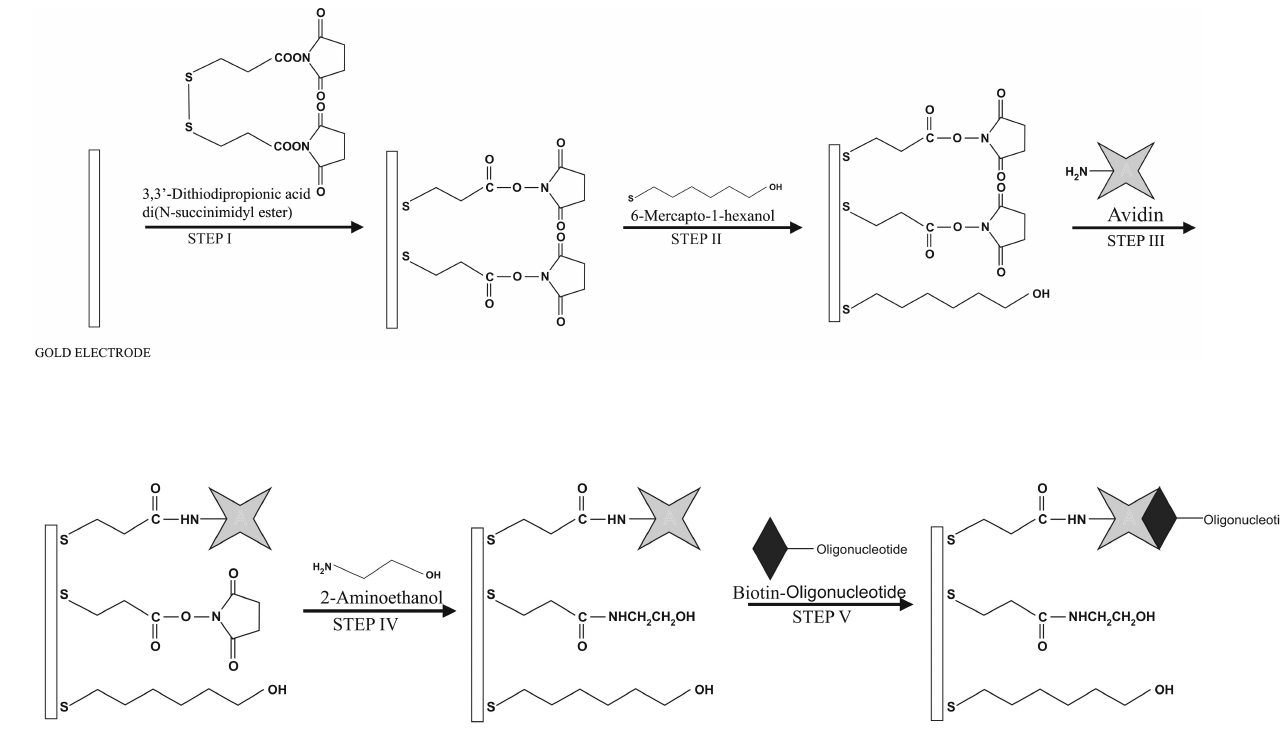
Figure 1. Steps of modification of the gold